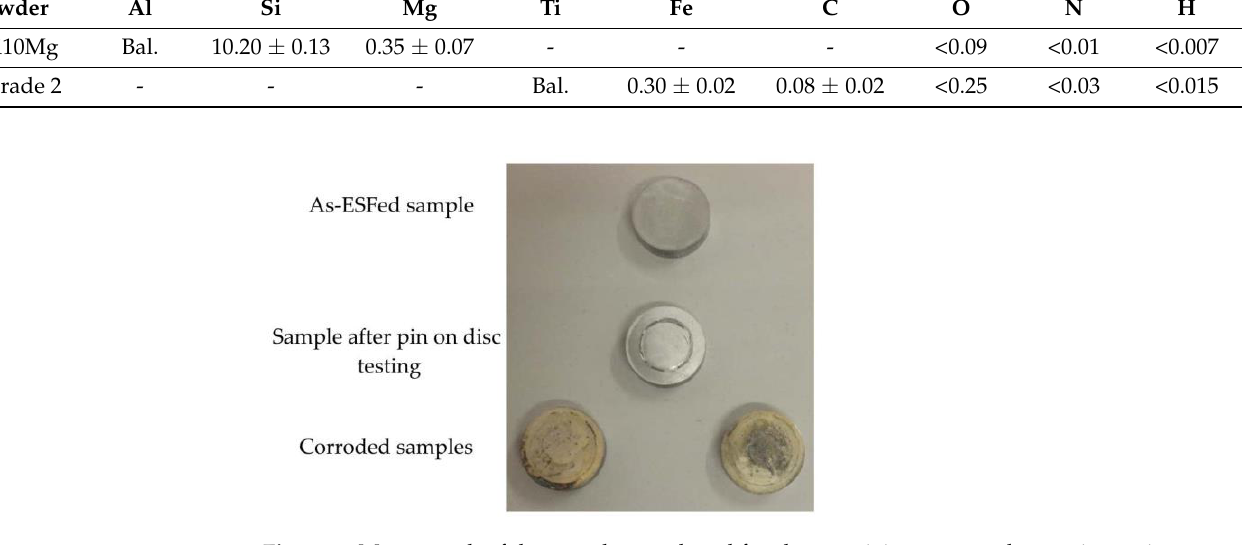
Figure 1. Macrograph of the samples employed for characterizing wear and corrosion